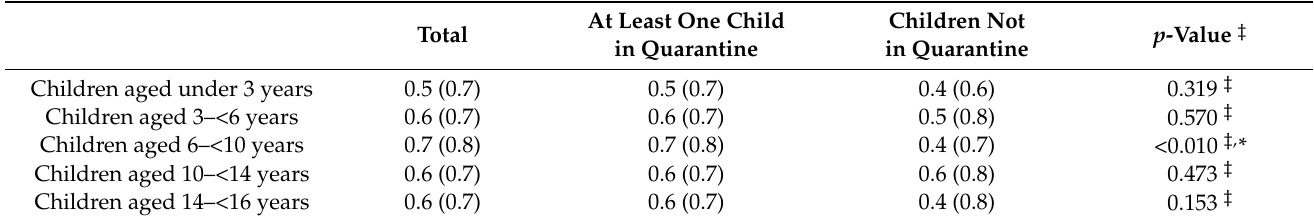
Table 3. Psychological distress score children in each age group; total scores and scores for at least one quarantined child versus none. At Least One Child Children Not Total in Quarantine in